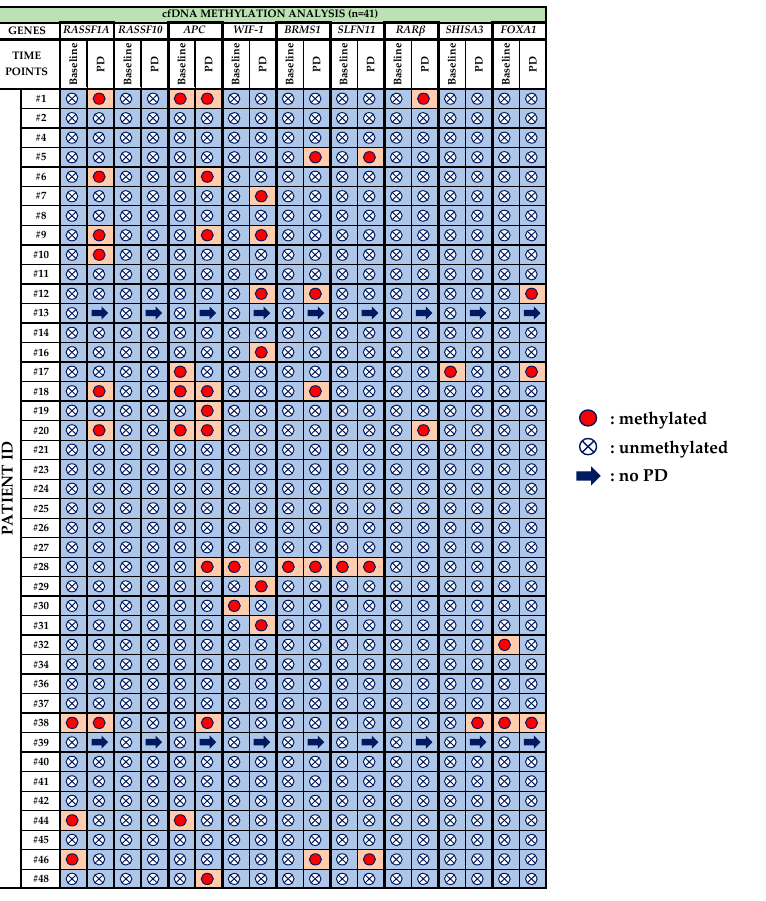
Figure 4. Methylation status of nine selected genes in plasma-cfDNA of NSCLC patients before osimertinib initiation ( n = 41) and at progression of disease ( n = 39).